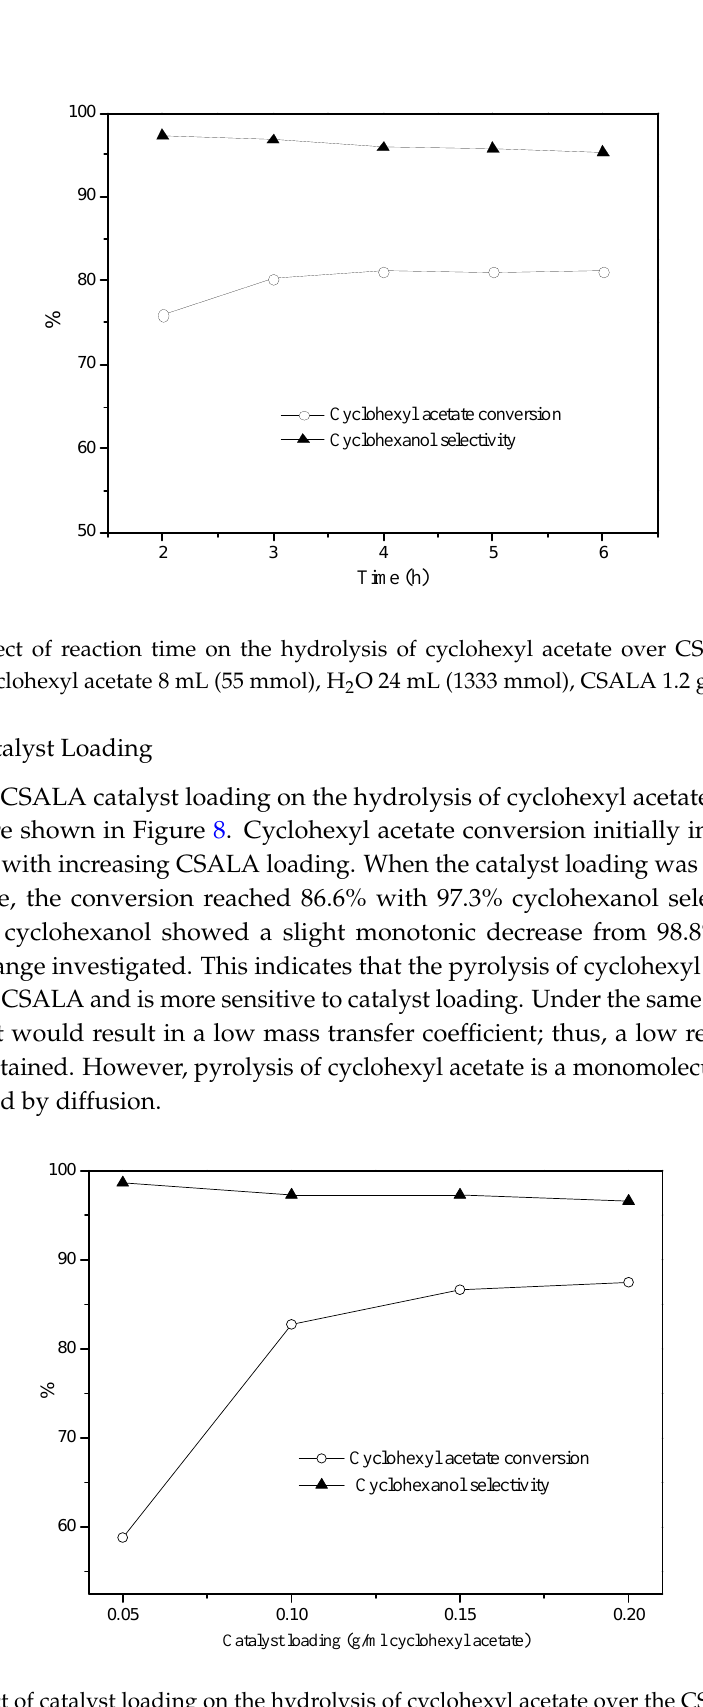
◦ C, 3 2 O 40 mL (2222 mmol), 130